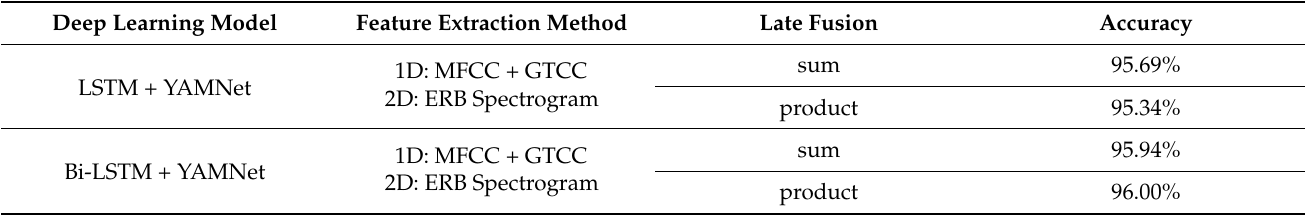
Table 6. Accuracy of two-stream-based SER models.